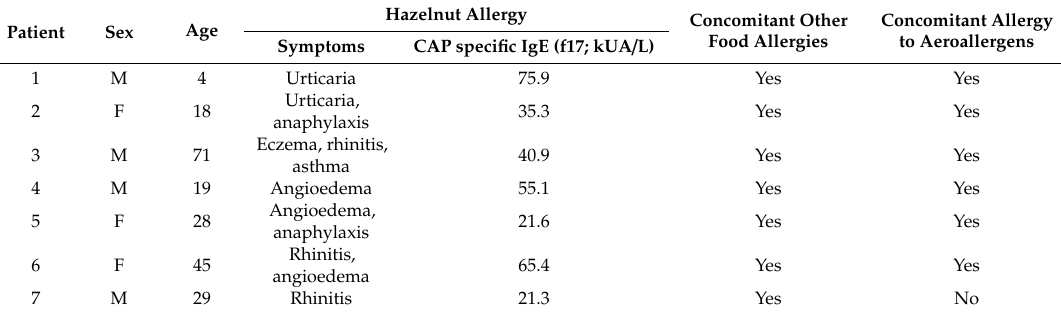
Table 1. Data from hazelnut allergic